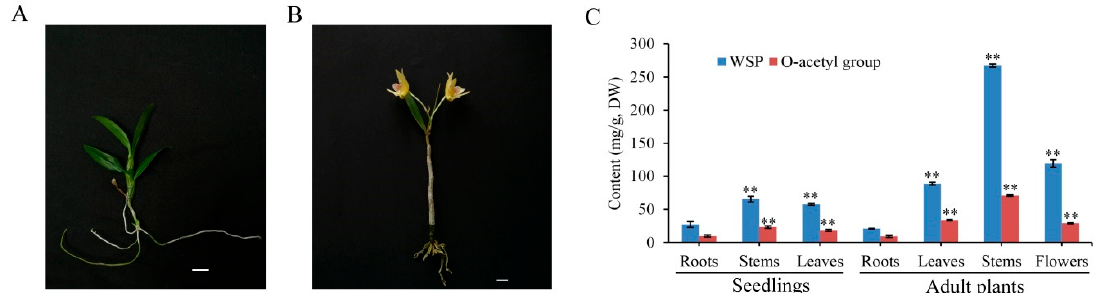
Figure 5. The metabolic accumulation of water-soluble polysaccharides (WSPs) and O -acetyl groups in different organs of Dendrobium officinale . ( A ) Ten-month-old seedling. Bar = 1 cm. ( B ) Adult plant. Bar = 1 cm. ( C ) The content of WSPs and related O -acetyl groups in different organs of seedlings and adult plants. Each data bar represents the mean ± SD ( n = 3). ** indicates p < 0.01 between the content of WSPs and O -acetyl groups in the roots of seedlings and in other organs of seedlings and adult plants according to DMRT.